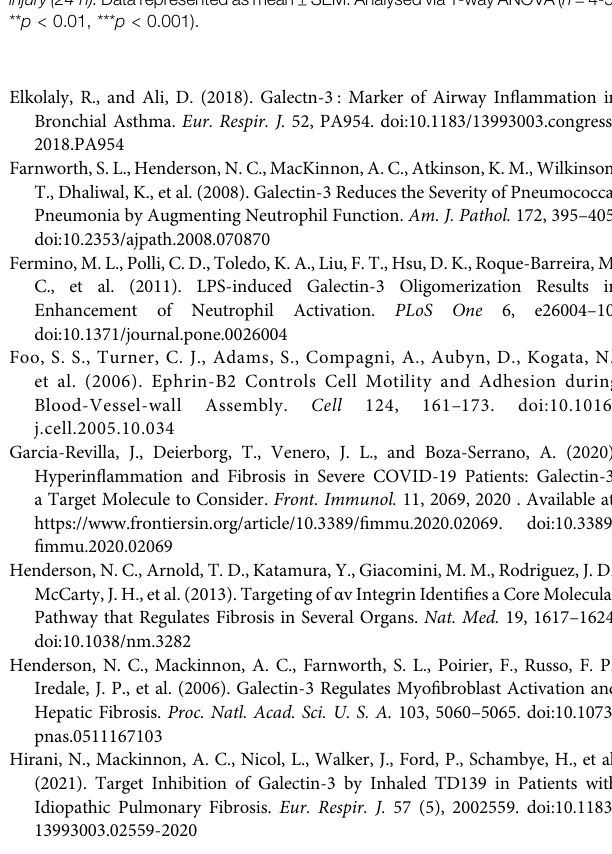
Supplementary Figure S4 | Pro fi le of neutrophils in blood and BAL neutrophil Gal- 3expressioninLysM-cre - ,LysM-cre + and Gal-3 − / − mice